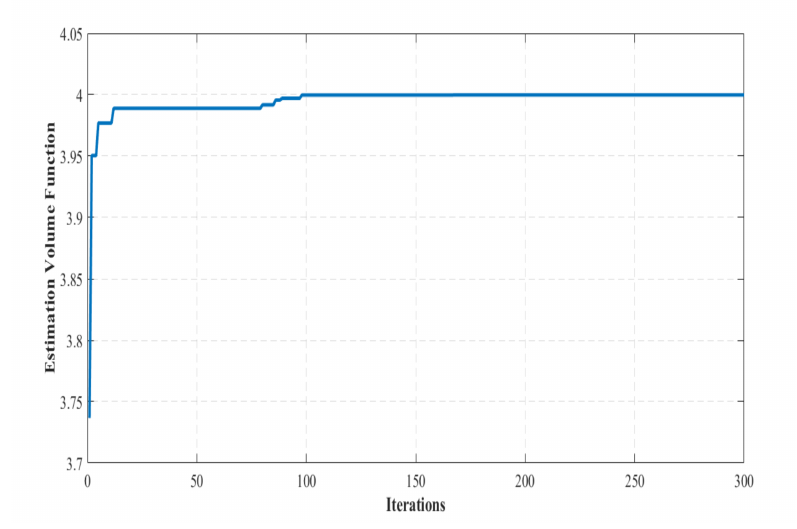
Figure 5. Evolution of Ω ( G ) using CPSO method for the Hahn model.